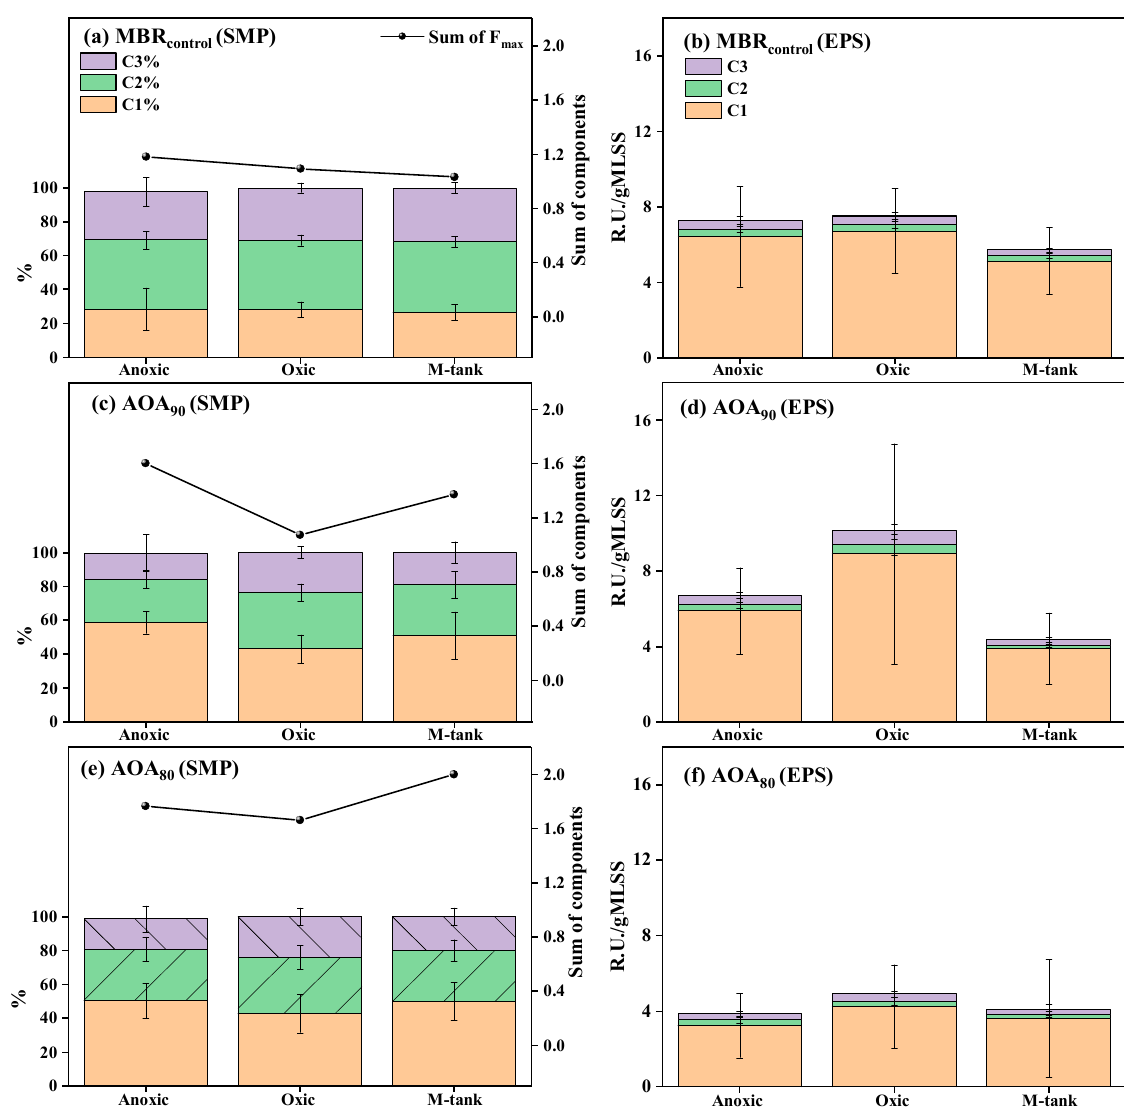
Figure 4. The average distribution of EEM-PARAFAC components and sum of F max (C1 + C2 + C3) in SMP and EPS of different units in ( a , b ) MBR control , ( c , d ) AOA 90 , and ( e , f ) AOA 80 ( n = 14).